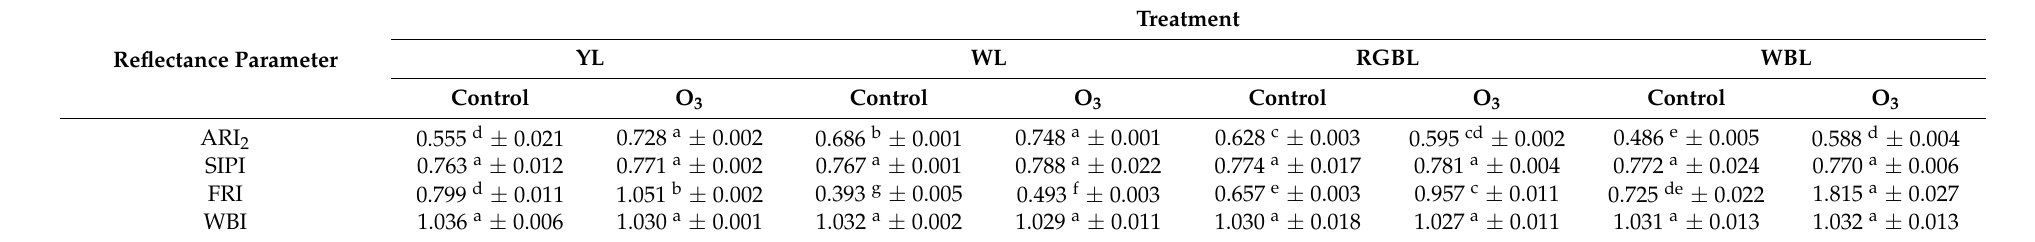
Table 3. Reflectance parameters from the leaves of Brassica rapa subsp. pekinensis growing in a different light spectrum and treated with ozone (100 ppb, 21 days) or non-fumigated (control). YL—yellow light (sodium lamp), WL—white light (LED), RGBL—red + green + blue light (LED) and WBL—white + blue light. Average values ( ± SD) marked with the same letters in the row do not differ significantly according to Duncan’s test, p ≤ 0.05, n = 7.